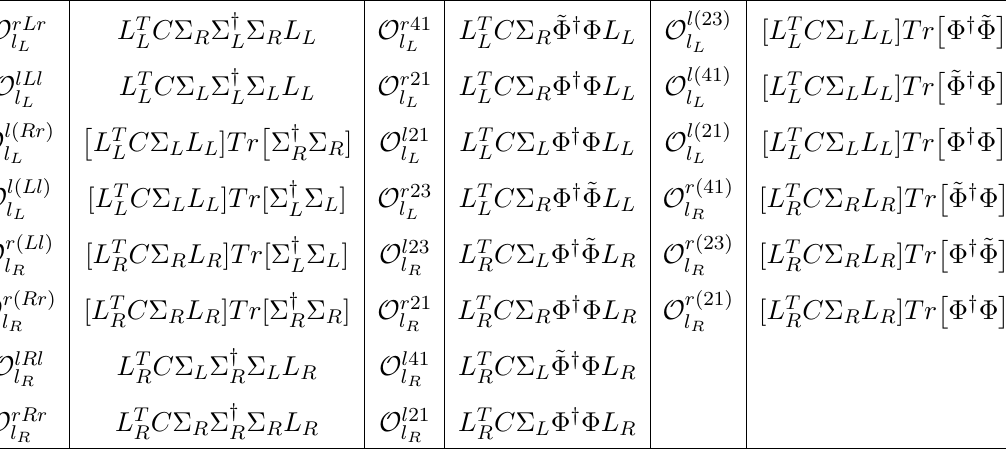
Table 21. MLRSM: 2 (cid:30) 3 [22 2 = 44] (Majorana type) class of operators. Each of these operators (cid:2) also has a distinct Hermitian Conjugate. Note (cid:6) L;R = i(cid:28) 2 (cid:1) L;R .